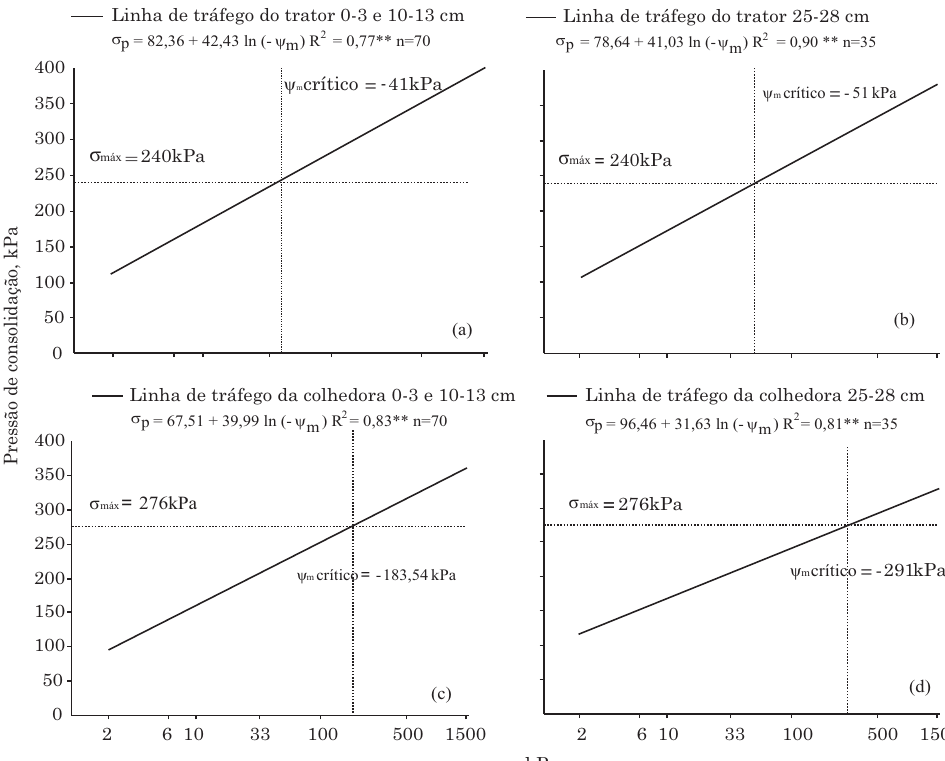
Figura 3. Modelo de capacidade de suporte de carga em função do potencial matricial (- ψψψψψ m ) em um Latossolo Vermelho-Amarelo (LVA) para a linha de tráfego do trator (LTT) e linha de tráfego da colhedora (LTC), em três camadas de estudo sob a cultura do café. A linha pontilhada horizontal representa a pressão máxima aplicada pelo rodado do trator e colhedora, e a linha pontilhada vertical representa o potencial matricial